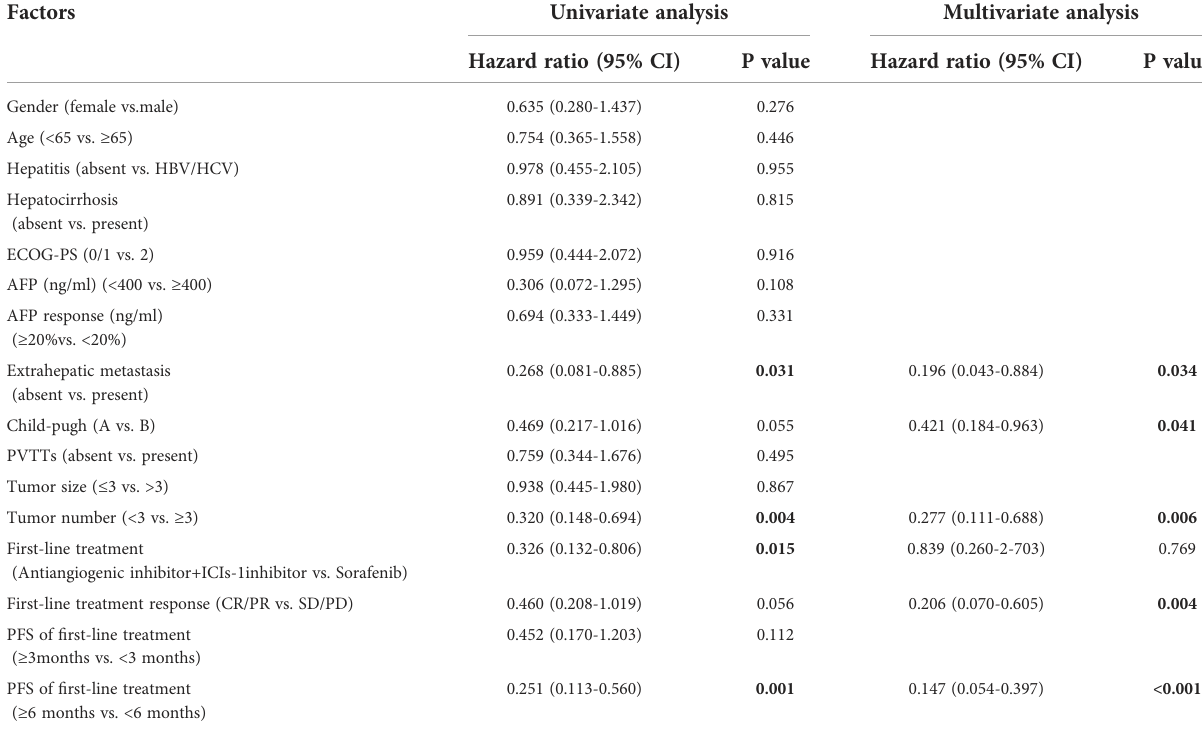
TABLE 5 Univariate and multivariate analysis of OS in the 50 patients with unresectable HCC who received lenvatinib as second-line treatment.